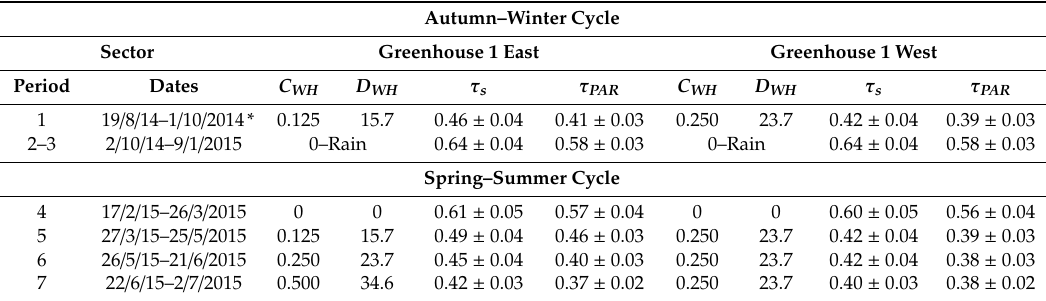
Figure 2. Relationship between CaCO 3 concentration in the solution applied in the greenhouse cover and the dose of product remaining under the plastic ( a ). Transmissivity in function of the whitening dose ( b ) for photosynthetic active radiation corresponding to wavelengths from 400 to 700 nm (·· ■ ··), ultraviolet light 380–400 nm (- (cid:7) -) and far red radiation 700–780 nm (- (cid:78) -). Table 2. Mean transmissivity ( ± standard deviation) for solar radiation τ s and for photosynthetically active radiation τ PAR measured in greenhouse 1 for the di ff erent whitening concentrations C WH (kg L − 1 ) and doses D WH (g m − 2 ) applied in both crop cycles.